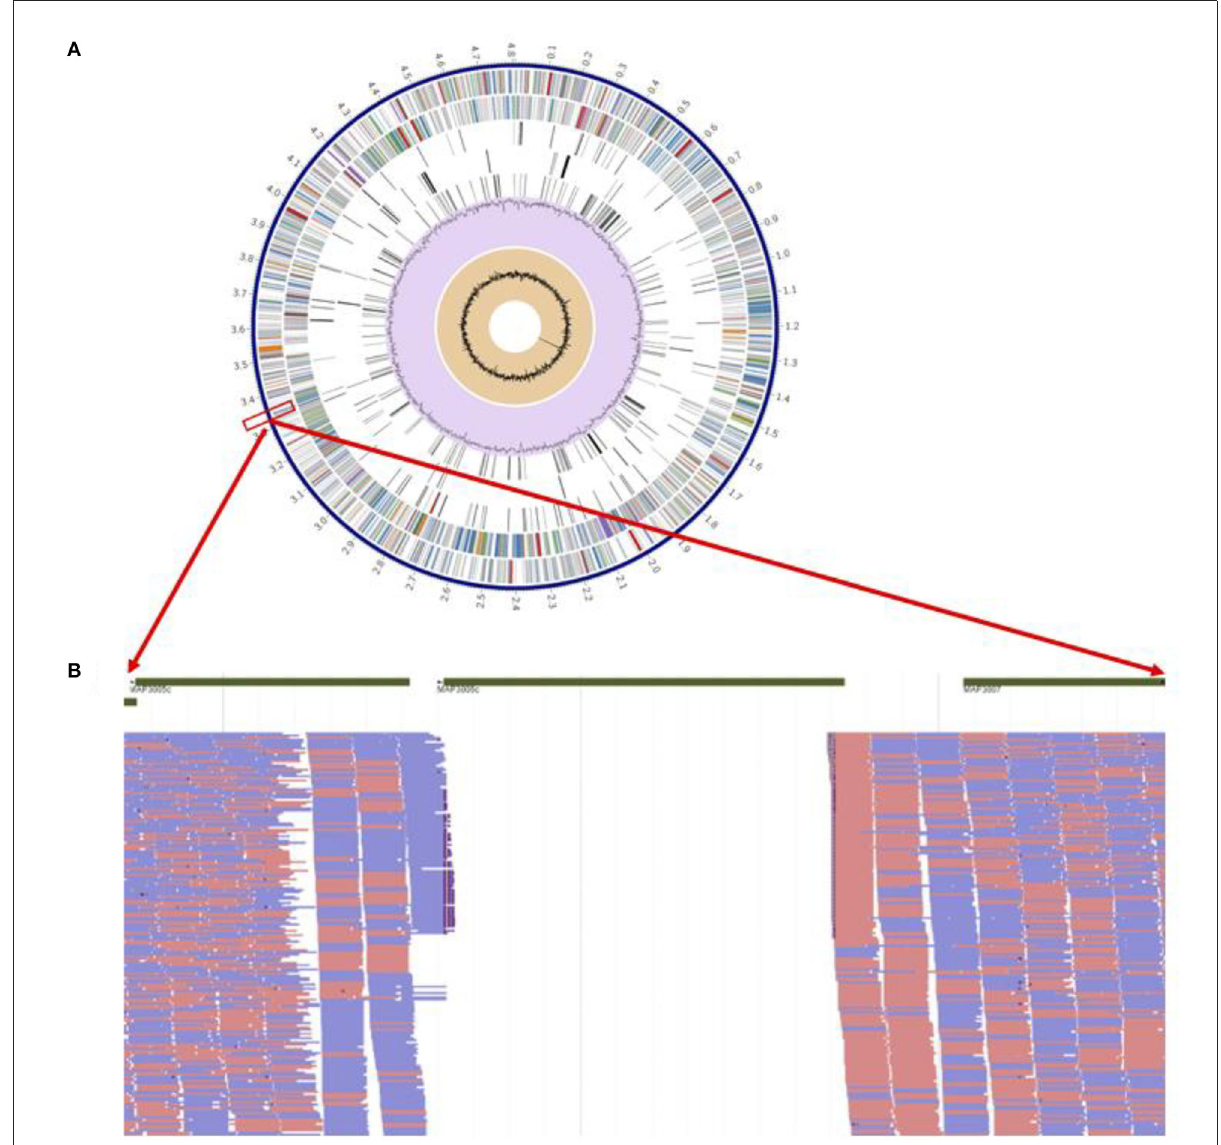
FIGURE2 Genome-wide analysis of live attenuated vaccine pgsN. (A) Annotated genes on the aligned M. paratuberculosis 1 lipN showing from outer to inner; scaffold of M. paratuberculosis k10, coding DNA sequences (CDS) on forward, CDS on reverse, non-CDS features, non-synonym mutations on forward CDS, non-synonym mutations on reverse CDS, GC content and GC skew. (B) Magnification of short reads aligned to areas flanking the lipN gene to confirm successful knockout of lipN by the absence of aligned